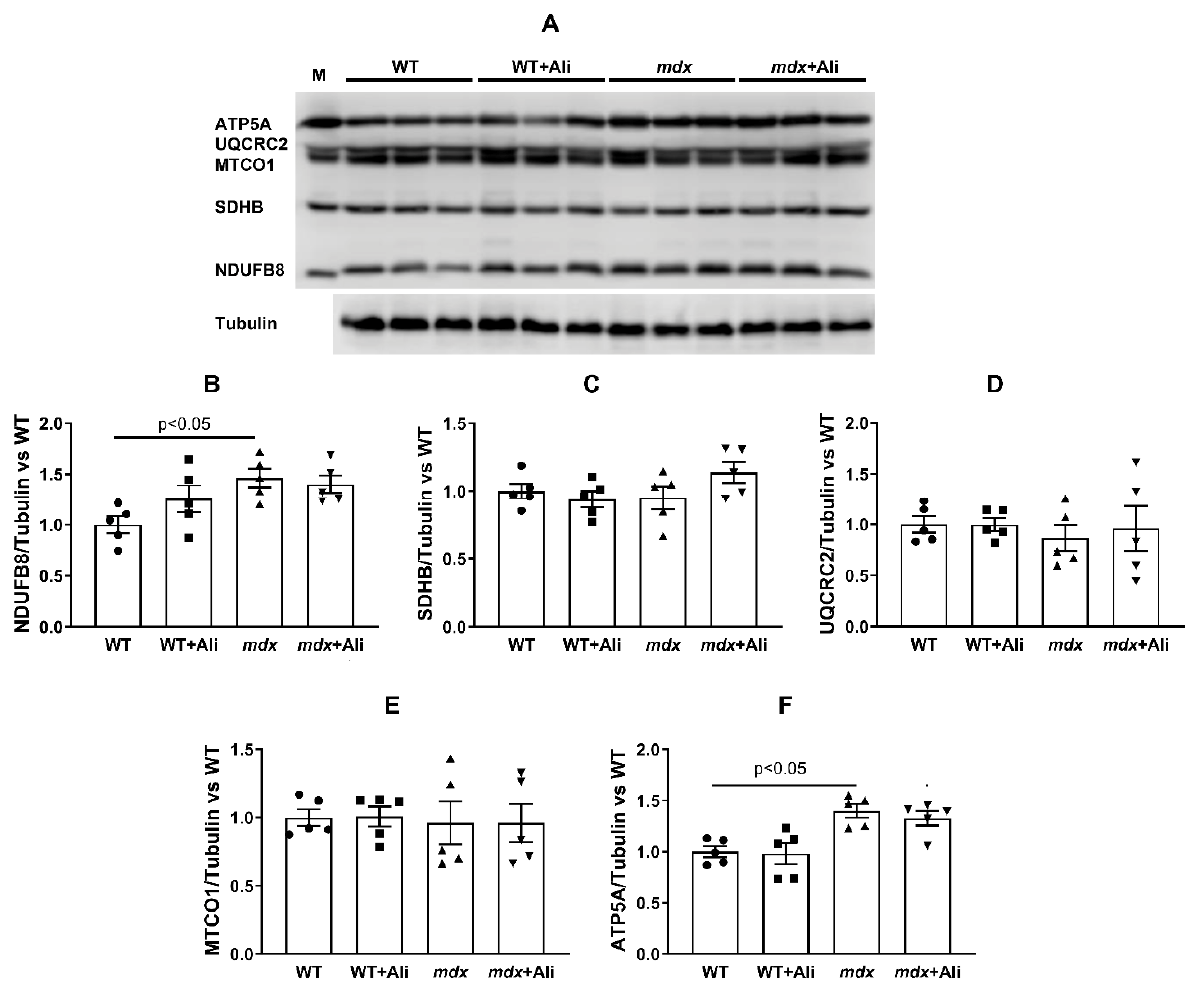
Figure 2. Levels of the proteins of mitochondrial respiratory chain complexes. Data of Western blot analysis ( A ). The letter “M” indicates a positive control (rat heart tissue lysate; mitochondrial extract). Relative contents of Complex I/tubulin ratio ( B ), Complex II/tubulin ratio ( C ), Complex III/tubulin ratio ( D ), Complex IV/tubulin ratio ( E ), and Complex V/tubulin ratio (ATP synthase, ( F )). The data are presented as means ± SEM ( n = 5).